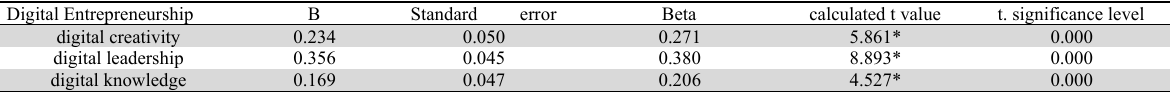
Results of multiple regression analysis to test the impact of digital Entrepreneurship on the digital supply chain in the Jorda- nian hotel sector Digital Entrepreneurship B Standard